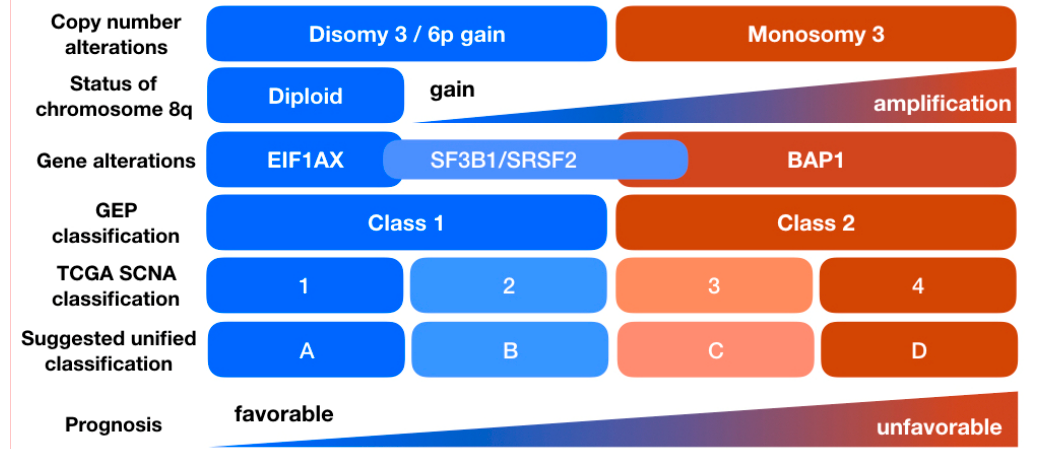
Figure 2. An overview of UM subtypes. Prognostic classes can be inferred from either somatic copy number alterations (SCNA), gene alterations, or gene expression. The A, B, C, and D classification was suggested to avoid confusion between the numerical classification used in both the Cancer Genome Atlas (TCGA) and the commercially available test (GEP classification).